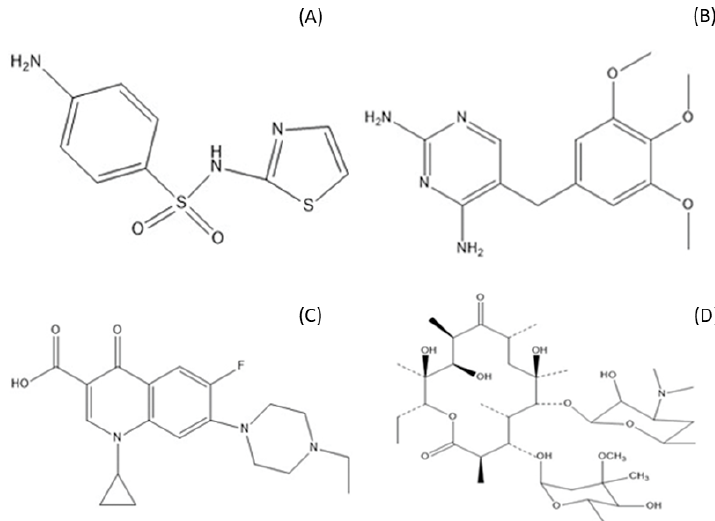
Figure 1. Chemical structures of ( A ) sulfathiazole (STZ), ( B ) Trimethoprim (TMP) ( C ) enrofloxacin (ENF) and ( D ) erythromycin (ERM).